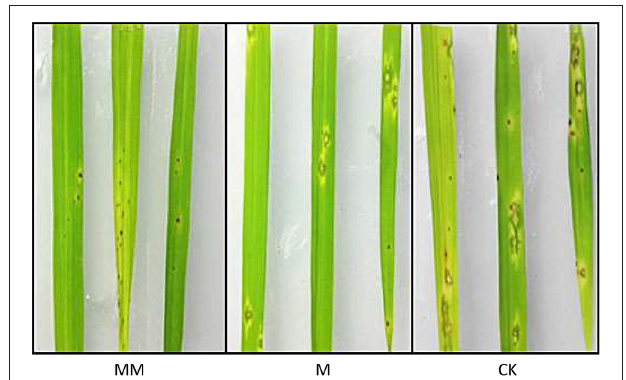
FIGURE 9 | Typical disease symptoms on leaves of MoHrip1-treated and control-treated rice plants. Rice plants were sprayed with M. oryzae spores after being treated with MoHrip1 or Tris-Cl 3 days. The MM group indicated that the rice seeds were immersed in MoHrip1 (10 µ g/mL) then sprayed with MoHrip1 (30 µ M) at the three-leaf stage. The M group indicated that the rice seeds were immersed in MoHrip1 (10 µ g/mL) then sprayed with Tris-Cl (25 mM) at the three-leaf stage. The CK group indicated that the rice seeds were immersed in H 2 O then sprayed with Tris-Cl (25 mM) at the three-leaf stage as a negative control.